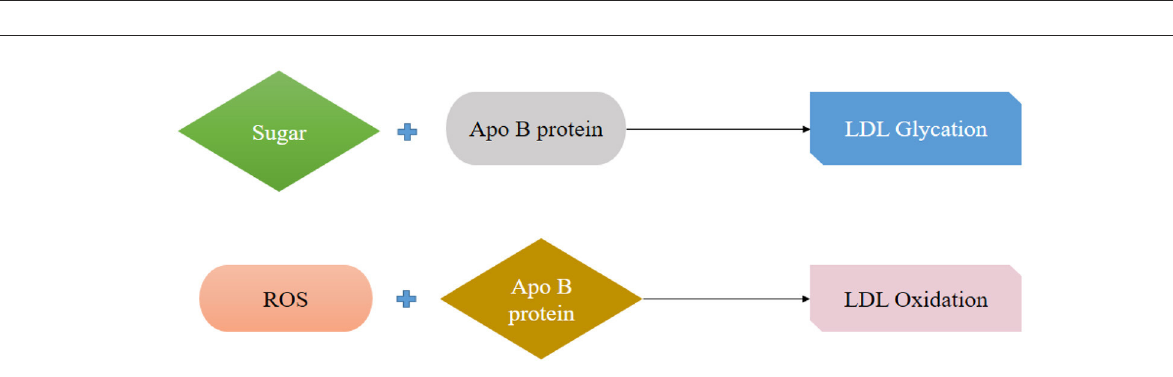
FIGURE5 Attachment of sugar with protein strand (Apo B) is called LDL glycation, modification of Apo B by Free radicals known as LDL